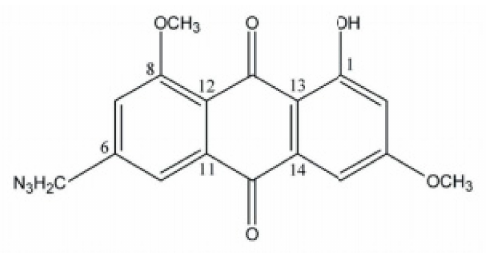
Figure 5. Chemical structure of emodin azide methyl anthraquinone